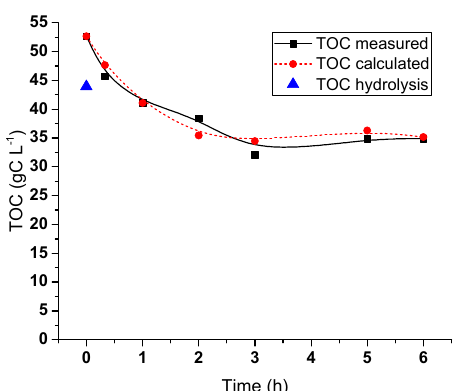
Figure 10. Hydrogenolysis of hemicelluloses liquor: comparison TOC measured, TOC calculated from chromatography, and TOC measured after hydrolysis with HCl.